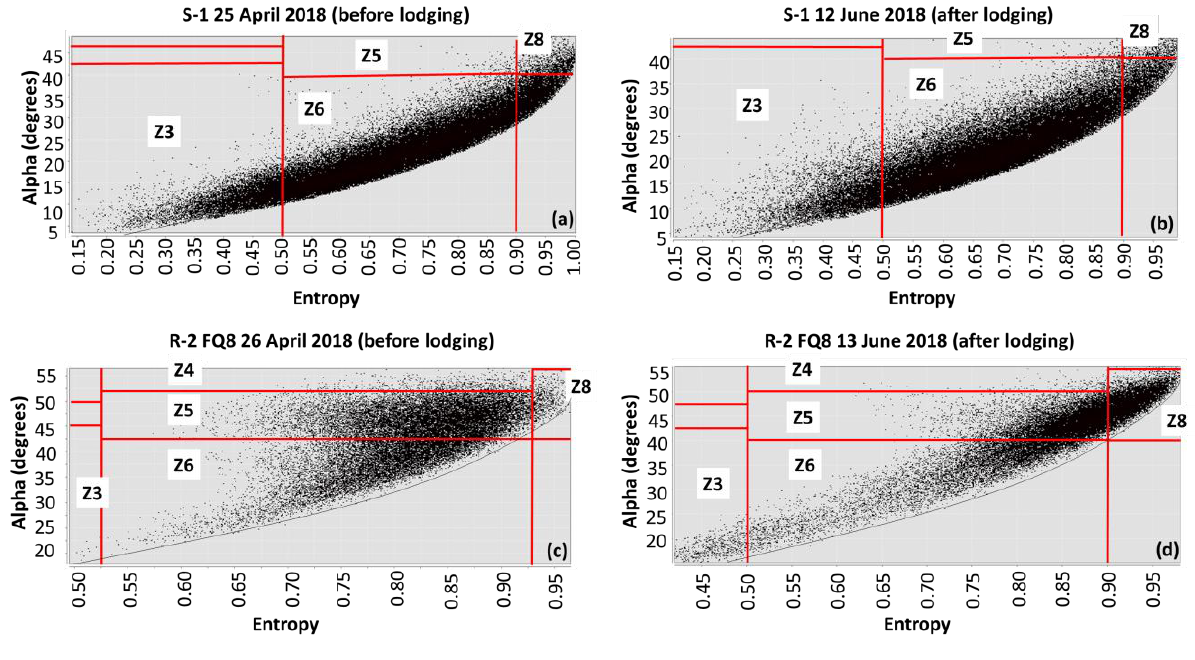
Figure 3. H-α classification planes from before and after lodging image pairs derived using near date (a), (b) Sentinel-1 (25 April, 12 June) and (c), (d) low incidence angle RADARSAT-2 FQ8 (26 April, 13 June) data.